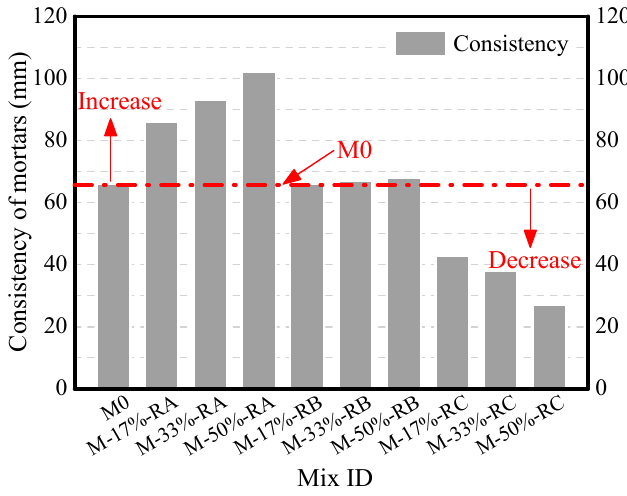
Figure 5. Consistency of crumb rubber mortars.